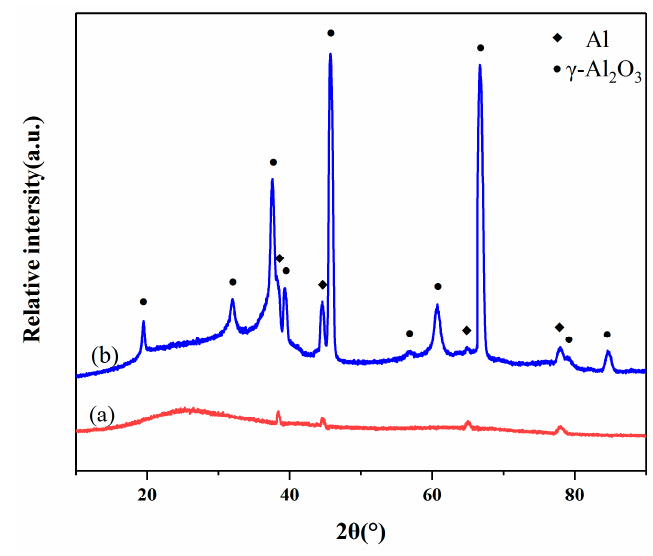
Figure 4. X-ray diffraction (XRD) patterns of the HA ( a ) and the MAO ( b ) coatings on 7050 Al alloys.